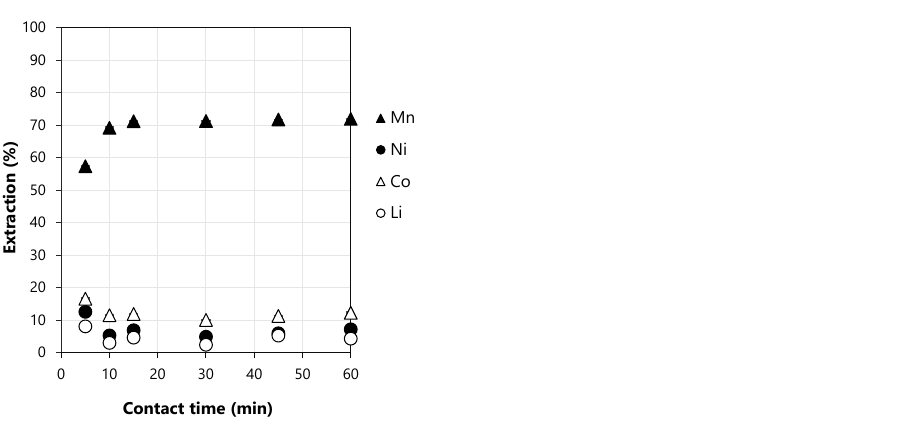
Figure 1. Extraction of metals at different leaching times. Conditions: O:A of 1:1; 0.5 M bis(2- ethylhexyl) phosphoric acid (D2EHPA) and pH of 3.5.